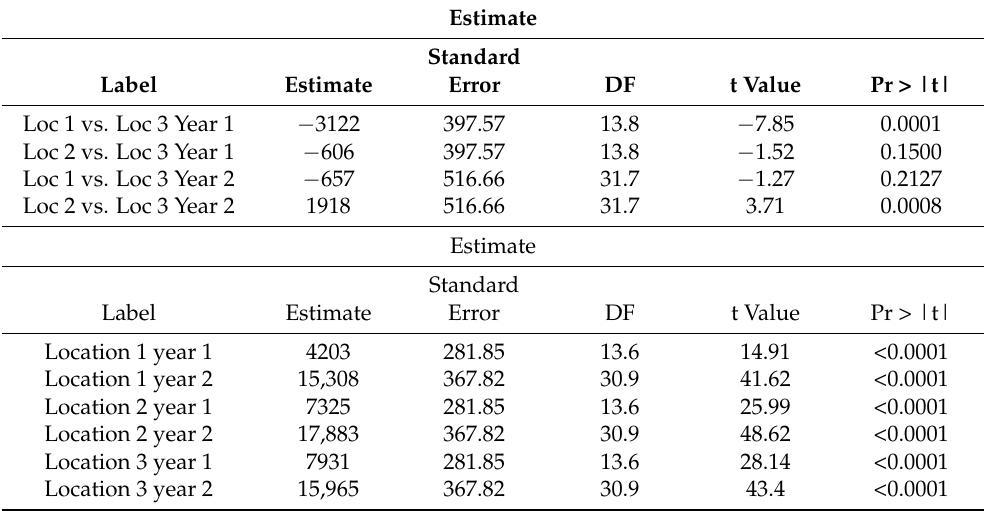
Table 7. Output 6: Partial output file of the statistical analysis on the location-by-year interaction effect for the alfalfa